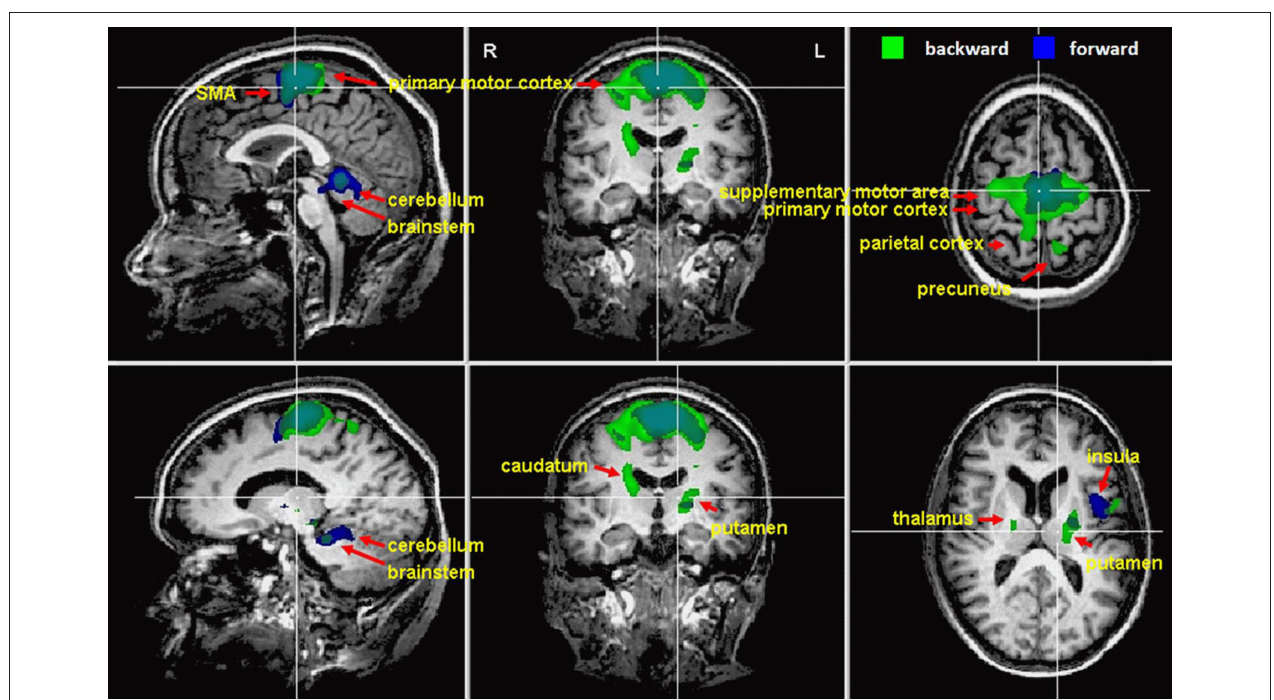
significant activations are shown with P -values corrected for multiple comparisons by false discovery rate (FDR, P < 0.05) and cluster threshold estimation using Monte Carlo simulations (alpha level =